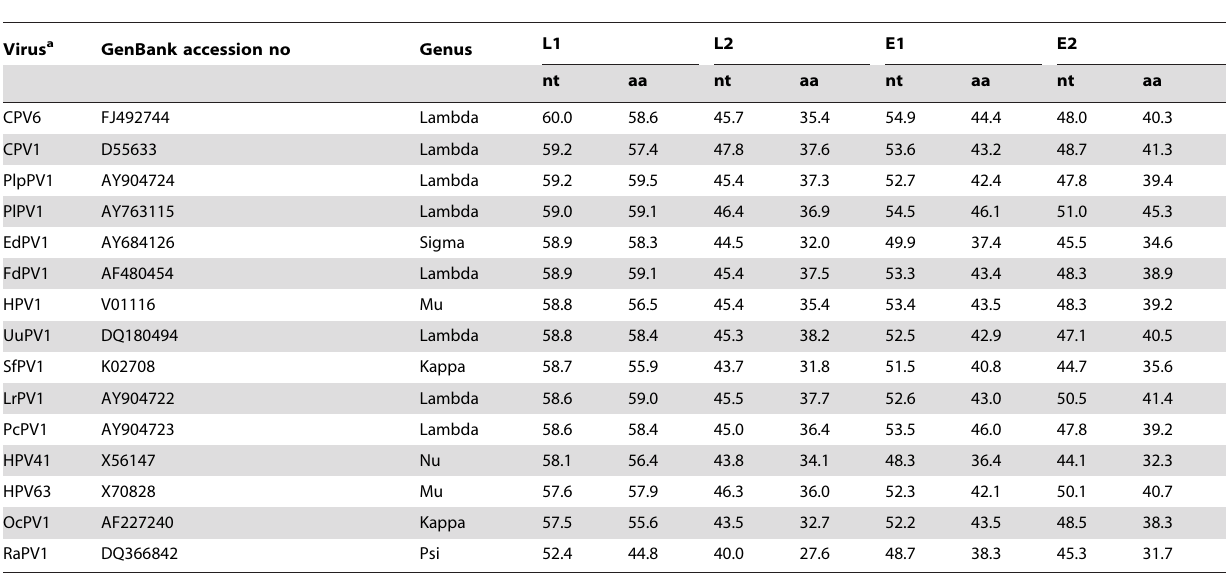
Table 2. MscPV1 nucleotide and amino acid identities with members of the genera Kappapapillomavirus, Lambdapapillomavirus, Mupapillomavirus, Nupapillomavirus, Sigmapapillomavirus, and Psipapillomavirus.